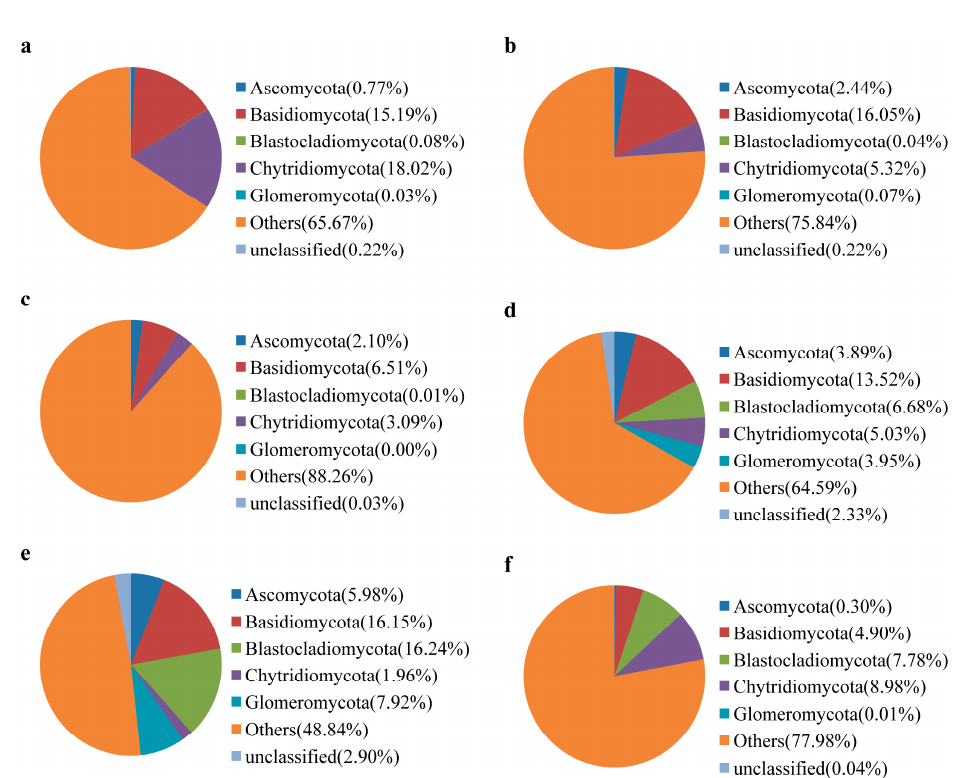
Figure 5. Taxonomic classification of water fungal community in Zhoucun drinking water reservoir during algal bloom outbreak and decline from July to September, 2012. Phylum levels using the Ribosomal Database Project classifier. a, b, c, d, e, f represent Jul. 13, Jul. 31, Aug. 16, Sep. 1, Sep. 15, Sep. 30 sampling date, respectively.